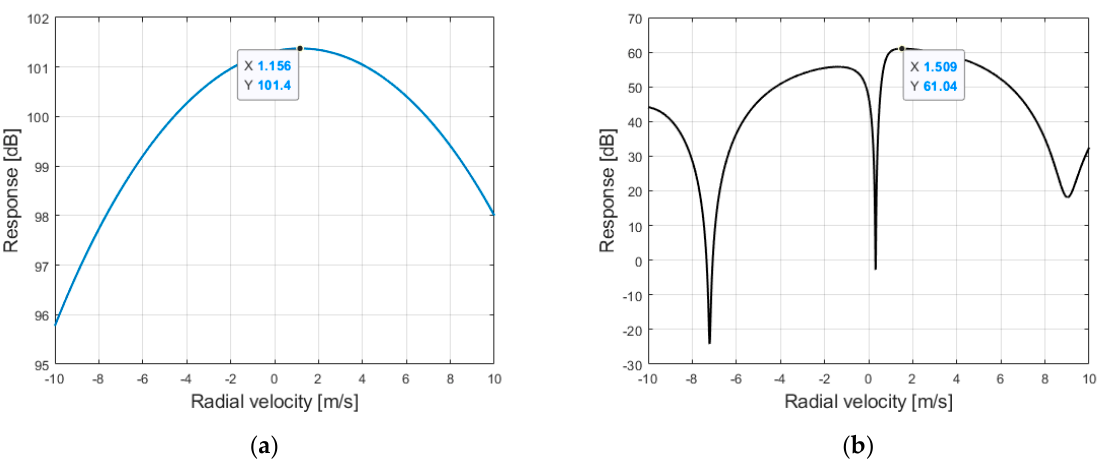
Figure 12. Velocity estimation function P out of T1: ( a ) the proposed method; ( b ) PD − STAP.